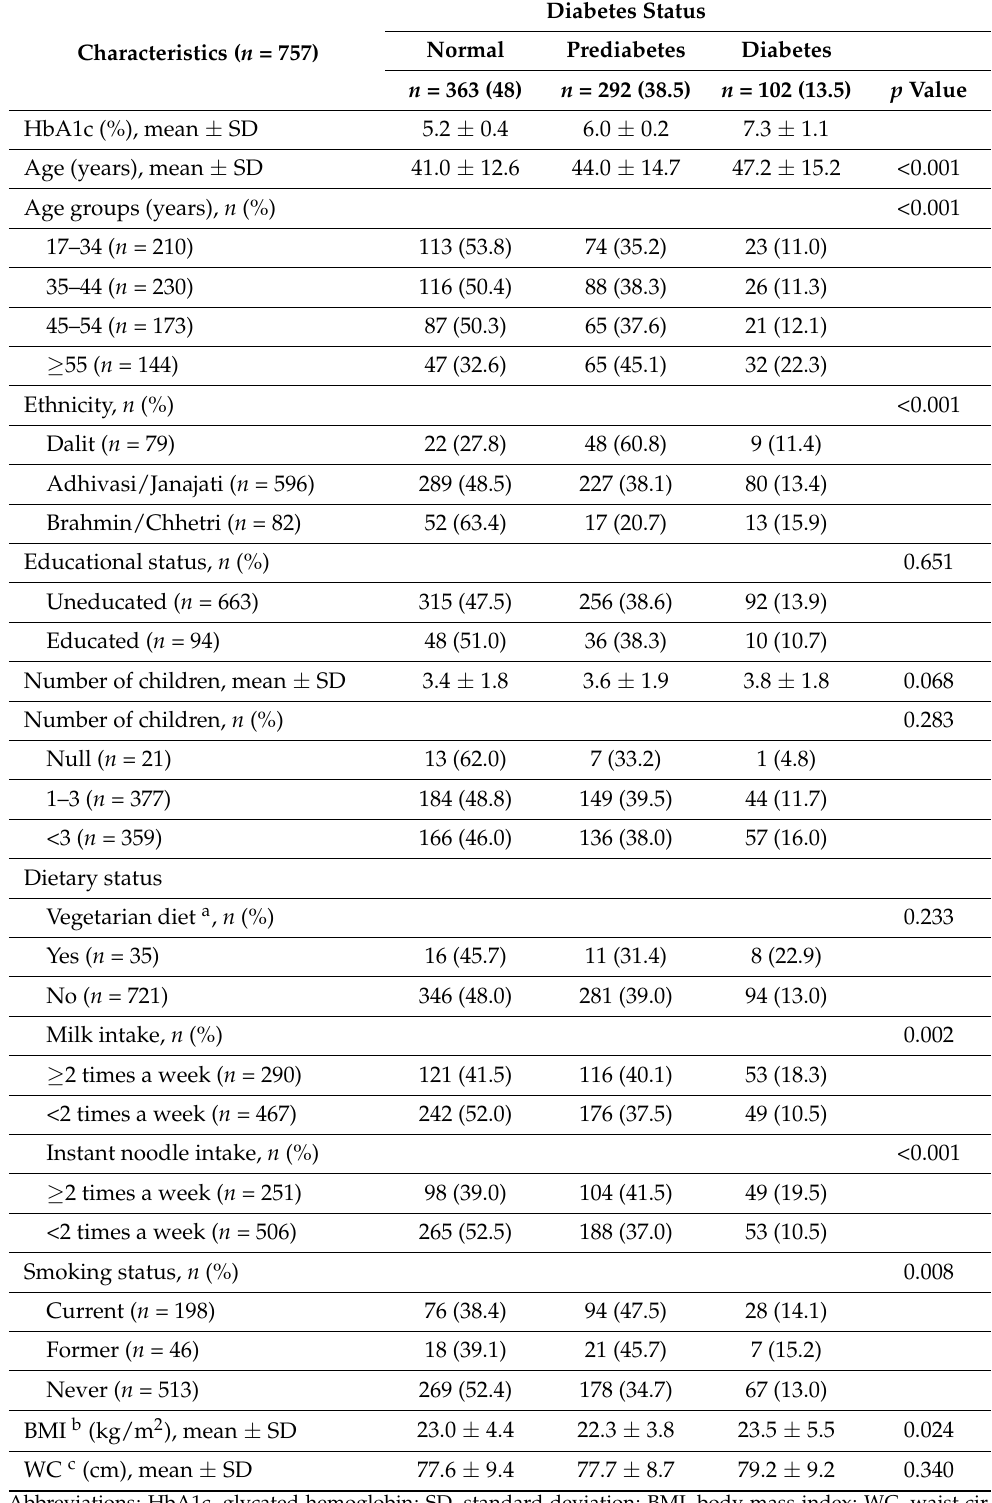
Table 2. Characteristics of the study population according to diabetes